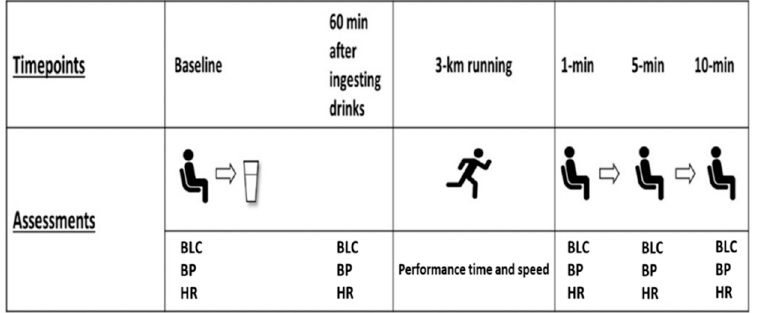
Figure 1. Study procedure BLC; blood lactate concentration, BP; blood pressure, HR; heart rate.